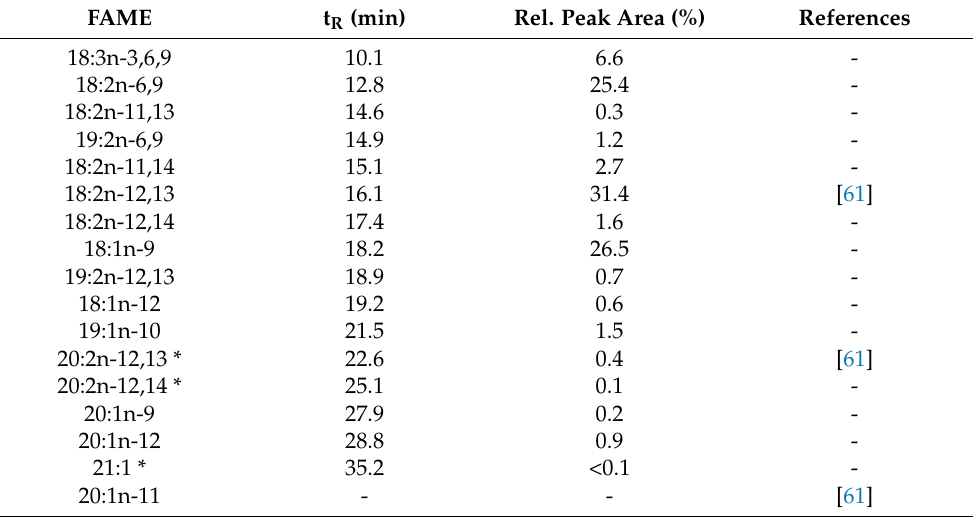
Figure 11. APCI MS/MS spectra of the [M + 55] + • adducts of conjugated FAMEs from Marrubium vulgare seeds interpreted as FAME 18:2n-11,13 ( A ) and 18:2n-12,14 ( B ). Table 4. FAMEs identified in TG fraction of Marrubium vulgare seed lipids. FAME t R (min) Rel. Peak Area